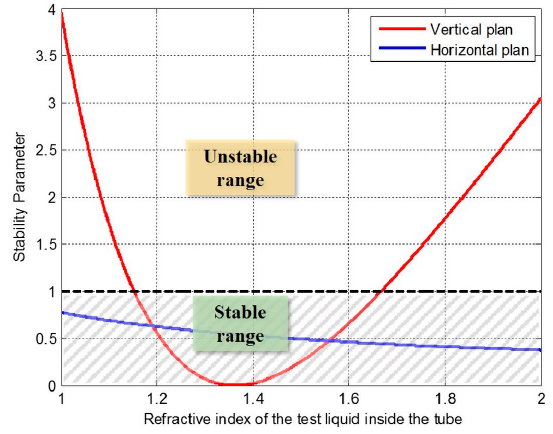
Figure 3. Schematic diagram for: ( a ) the horizontal cross section and ( b ) the vertical cross section, of the cylindrical Fabry-Pérot cavity with the micro tube inside indicating the design parameters and geometry.